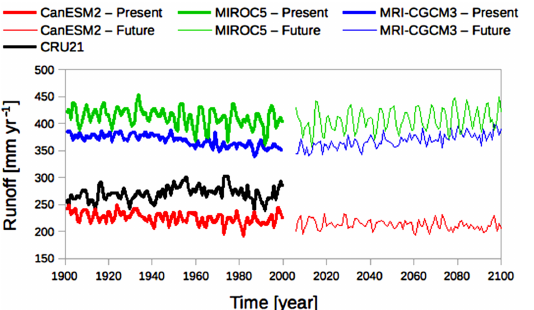
Figure 1. Annual estimates from GCM simulations under present and projected future conditions in contrast with observed climate forcings from the Climate Research Units, University of East An-